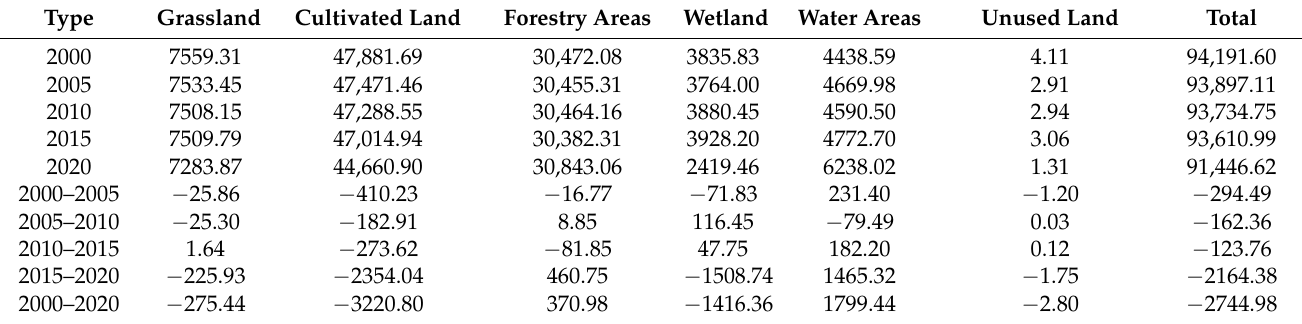
Table 4. ESVs of all land use types in the RAMR from 2000 to 2020 (million